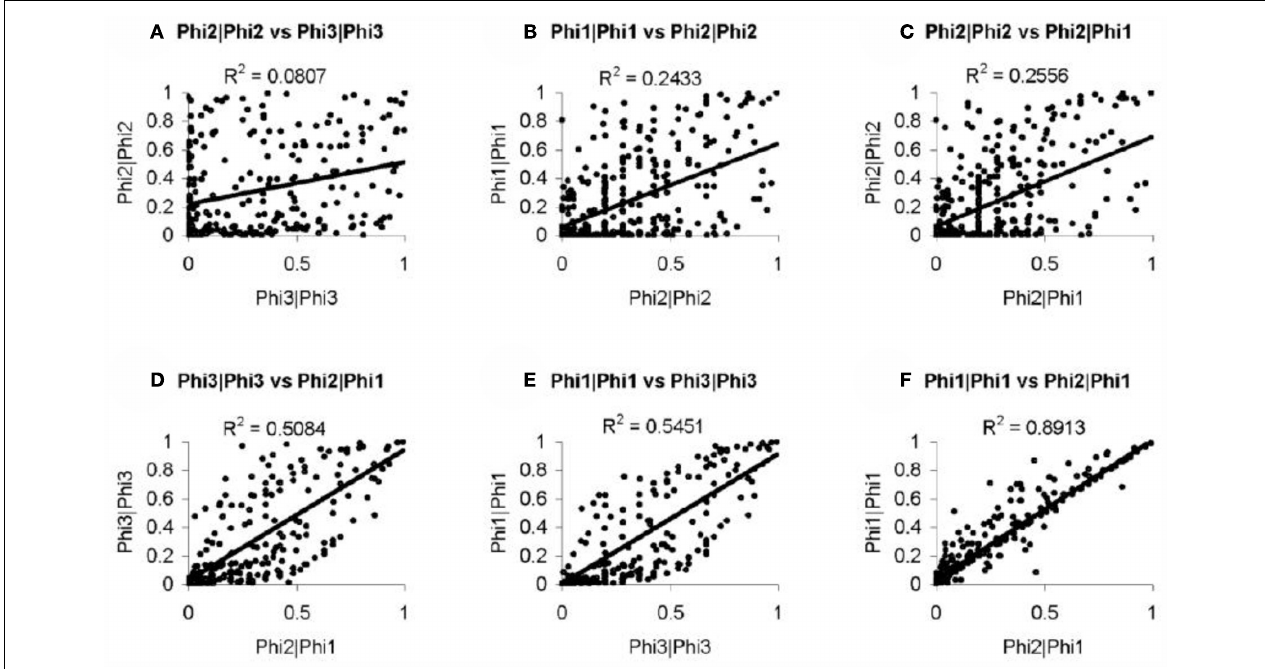
FIGUREA2 | Method comparisons (A–F) pair-wise p -value comparisons between methods, these scatter pots show the degree of agreement between methods. R 2 values are provided as a summary of the agreement.